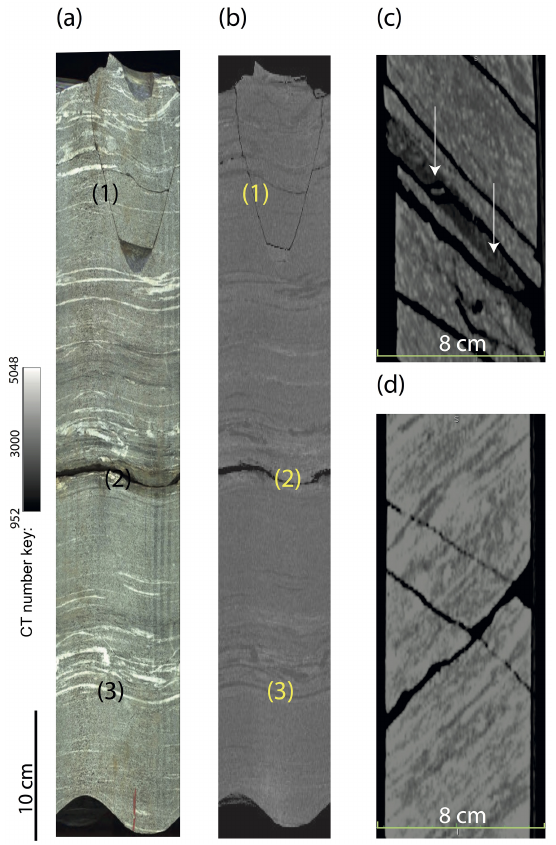
Figure 10. Fractures in the AHP drill core. Unrolled images of AHP drill core (BH1 45-2, 124.3–124.9m) taken by (a) DMT core scan- ner and (b) generated from a CT image. (1) Identifies fracture cut- ting across foliation, (2) foliation-parallel fracture with alteration halo, (3) foliation defined by quartzofeldspathic bands that have low CT numbers. ( c , d ) Core-axial parallel CT image slices of AHP drill core. In panel (c) , white arrows point to a “crush zone” sub- parallel to foliation (BH2 75-2, 155.92–156.04m). Panel (d) shows more variable fracture orientations identified in BH4 (section 70-4, 196.62–196.80m).